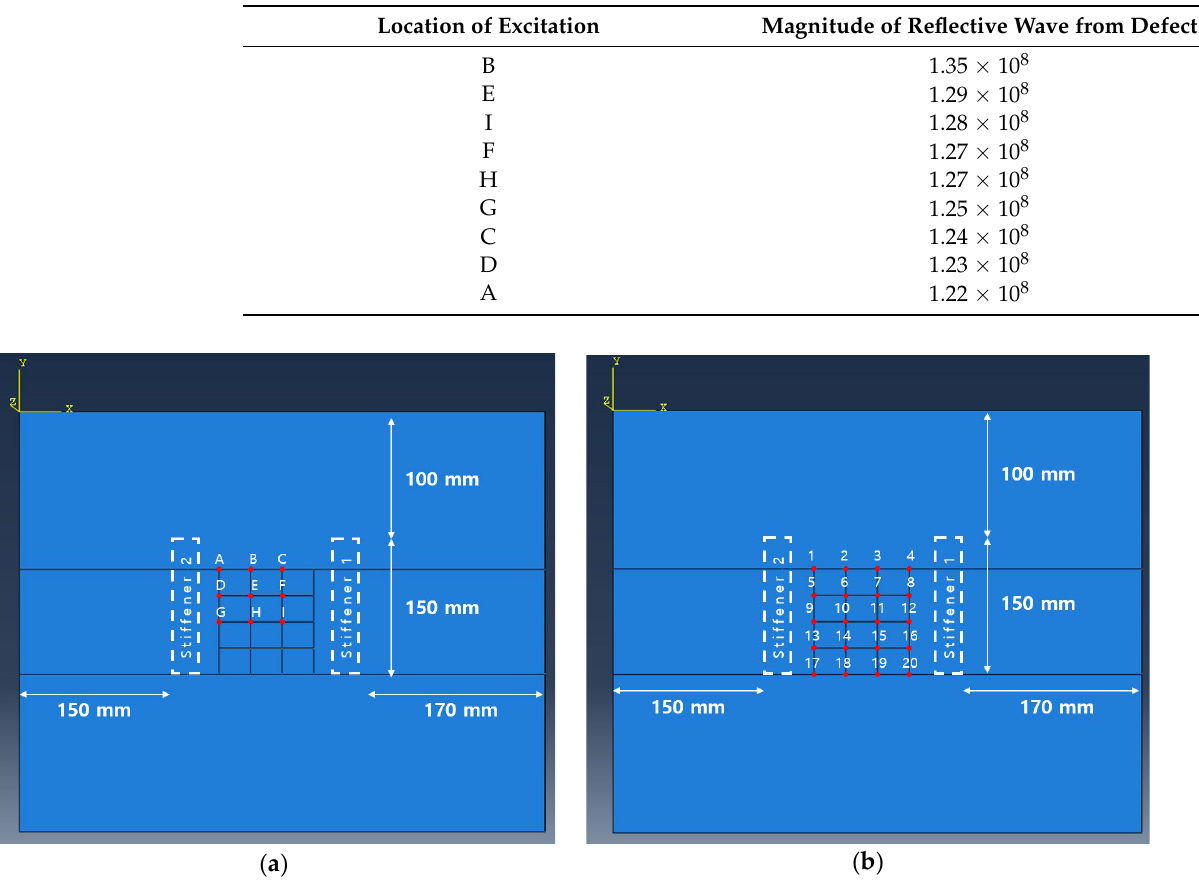
Table 3. Summed magnitudes of defect - induced reflective waves for each excitation location.